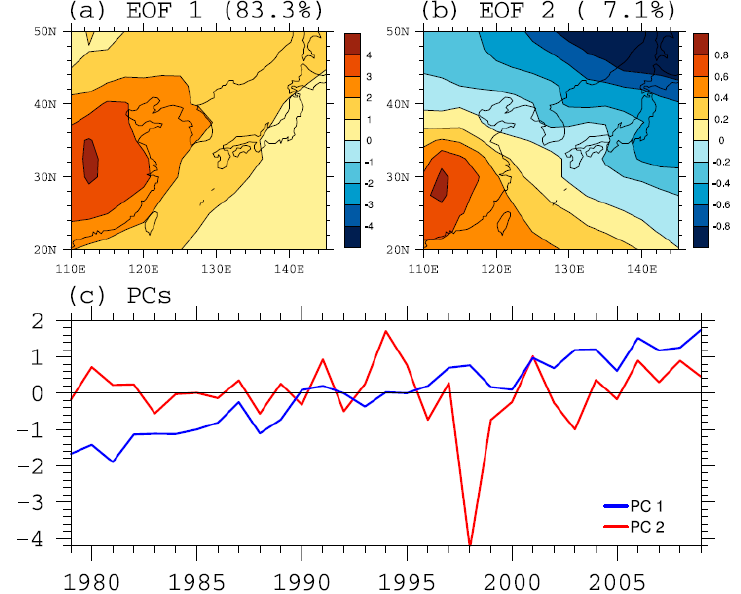
Figure 2. ( a ) The first and ( b ) second empirical orthogonal function (EOF) patterns of summer (June– July–August) near-surface (850 hPa) ozone MMM anomaly over the East Asian region (20° N–50° N, 110° E–145° E). ( c ) The corresponding principal component (PC) time series.